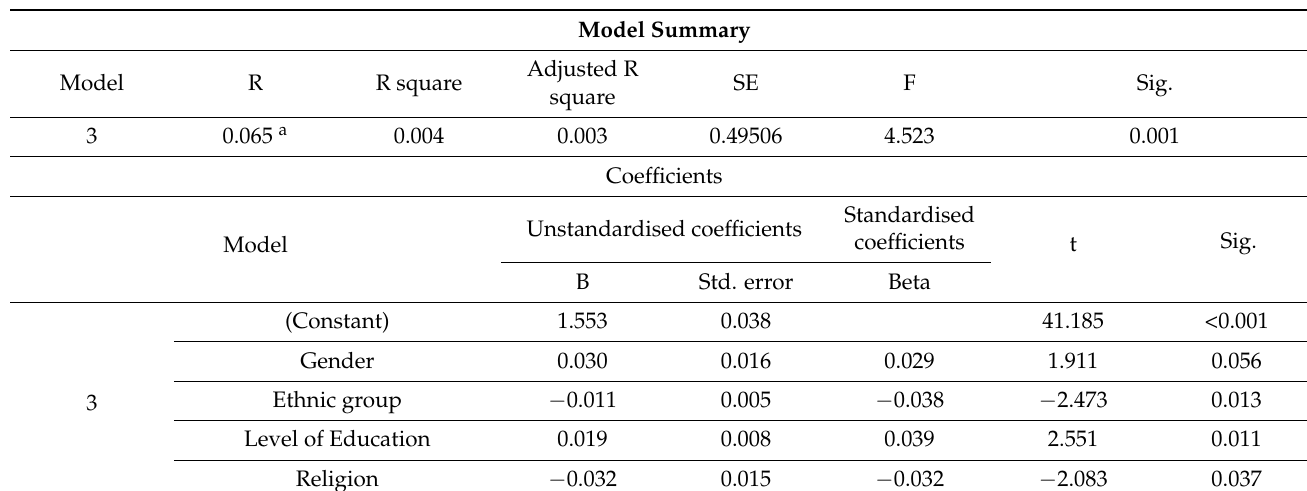
Table 7. Regression analysis for total attitude